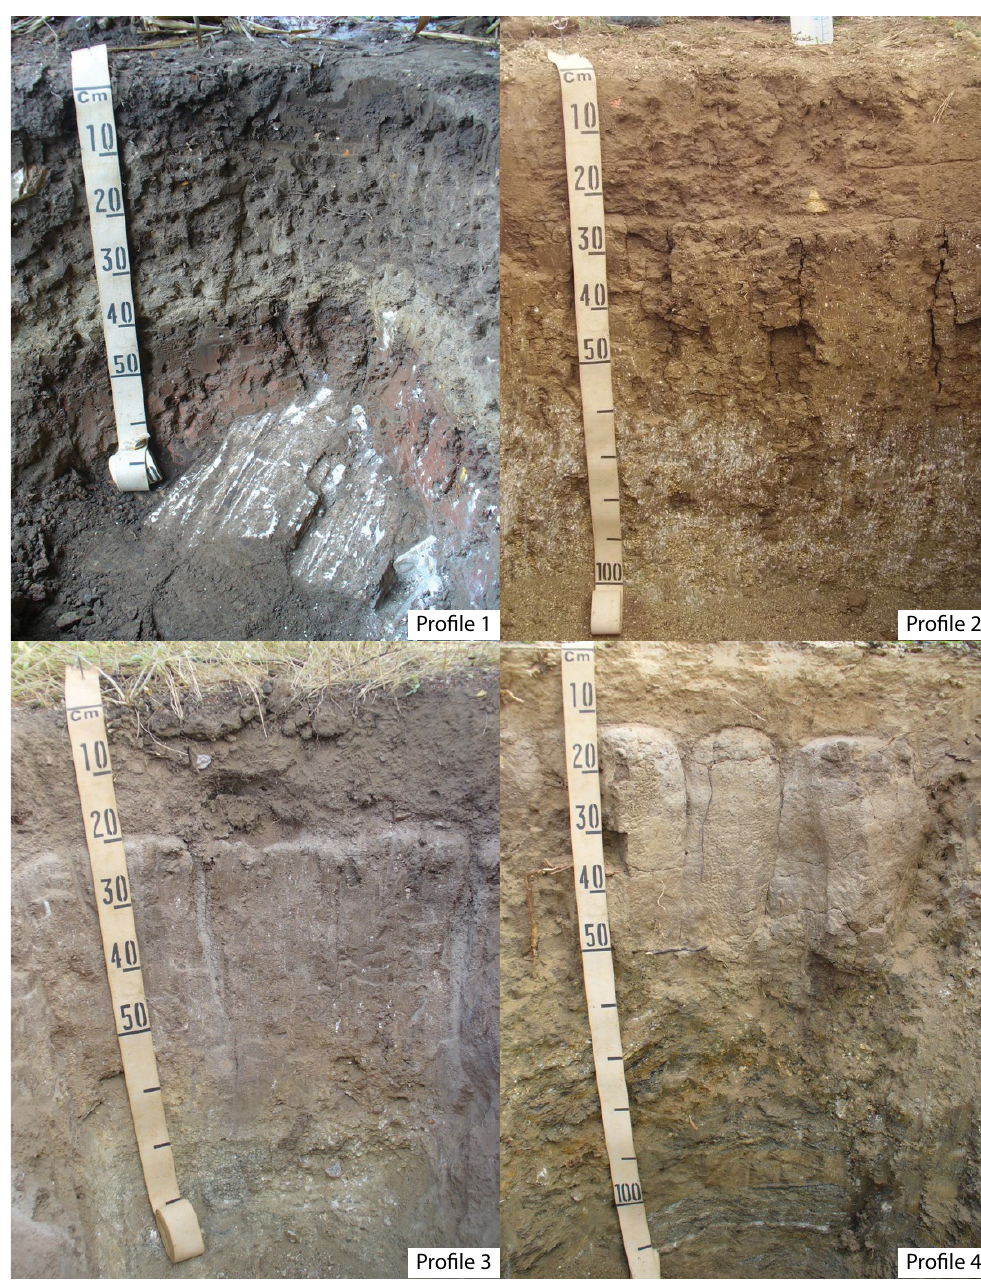
Figure 2. Soil profiles studied (a) profile 1 – Planossolo Háplico Eutrófico solódico (Typic Albaqualf); (b) profile 2 – Planossolo Háplico Eutrófico solódico (Typic Albaqualf); (c) profile 3 – Planossolo Nátrico Órtico típico (Typic Natraqualf); (d) profile 4 – Planossolo Nátrico Órtico salino (Typic